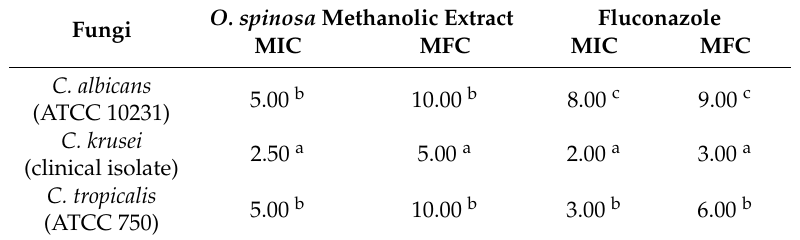
Table 3. Activity of O. spinosa extract and a reference compound fluconazole against biofilm (plaque) formation of Candida strains (MIC and MFC, mg /